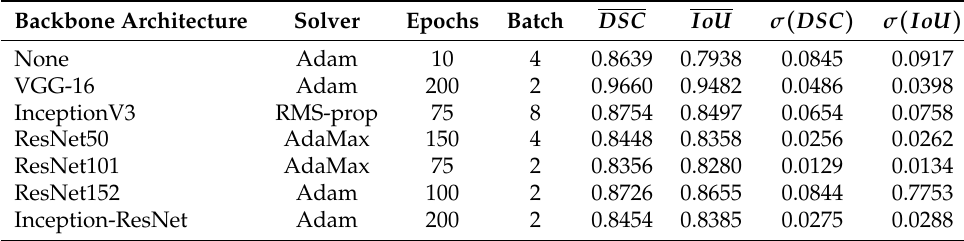
Table 9. Results achieved with images in the sagittal